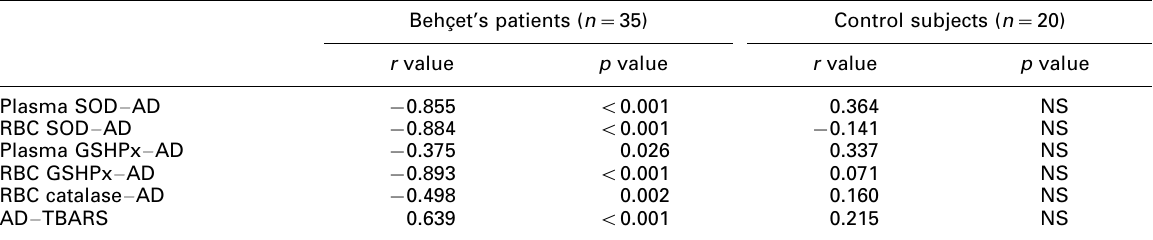
Table 4. Correlation analysis between superoxide dismutase, glutathione peroxidase, catalase, adenosine deaminase and thiobarbituric acid-reactive substances in patients with Behc¸et’s